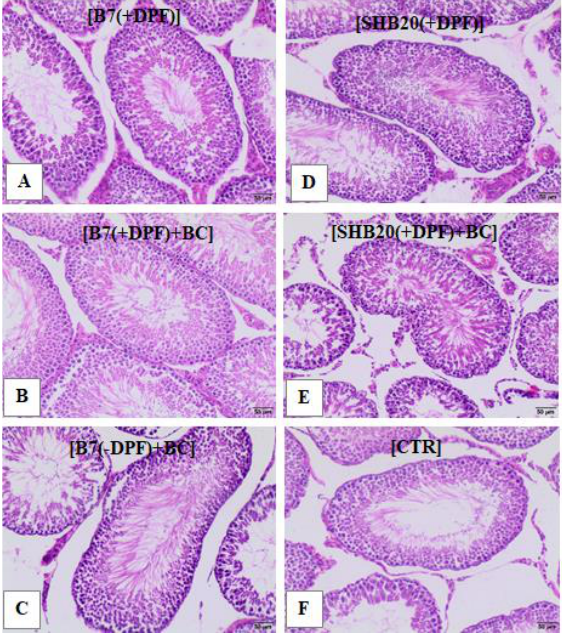
Figure 4. Representative microphotographs of hematoxylin-eosin-stained cross sections of testes of rats exposed to DEE from B7 or SHB20 biofuels with or without DPF-treatment and with or without blackcurrant pomace supplementation (BC) for 28 days. Testes of rats exposed to ( A ) filtered DEE from B7 biodiesel blend, ( B ) filtered DEE from B7 biodiesel blend and fed with feed with BC pomace, ( C ) unfiltered DEE from B7 biodiesel blend and fed with BC pomace, ( D ) filtered DEE from SHB20 biodiesel blend, ( E ) filtered DEE from SHB20 biodiesel blend and fed with feed with BC pomace, and ( F ) testes of control rats. B7 — 1st generation biofuel; SHB20 — 2nd generation biofuel; BC — blackcurrant pomace; DPF — diesel particulate filter; CTR — control group. Images were captured at 400× magnification; s cale bars correspond to 50 μm.